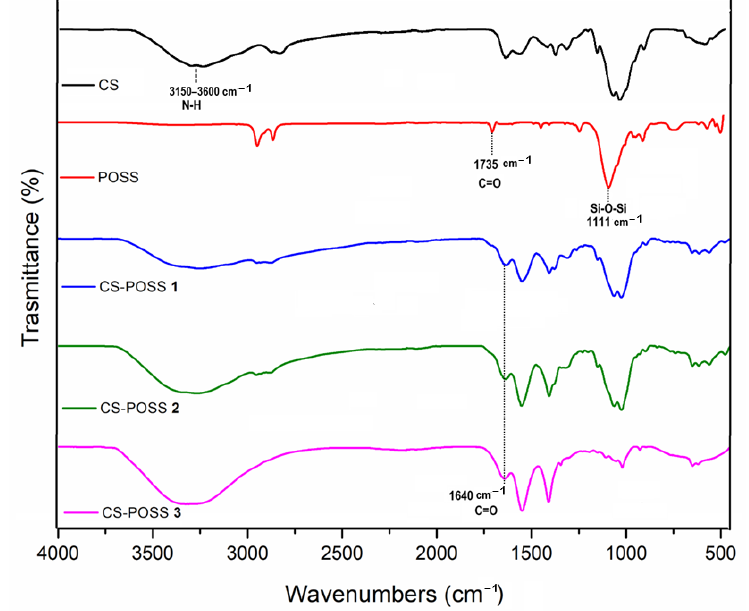
Figure 2. FTIR spectra of samples CS, POSS, CS-POSS 1, CS-POSS 2, and CS-POSS 3.